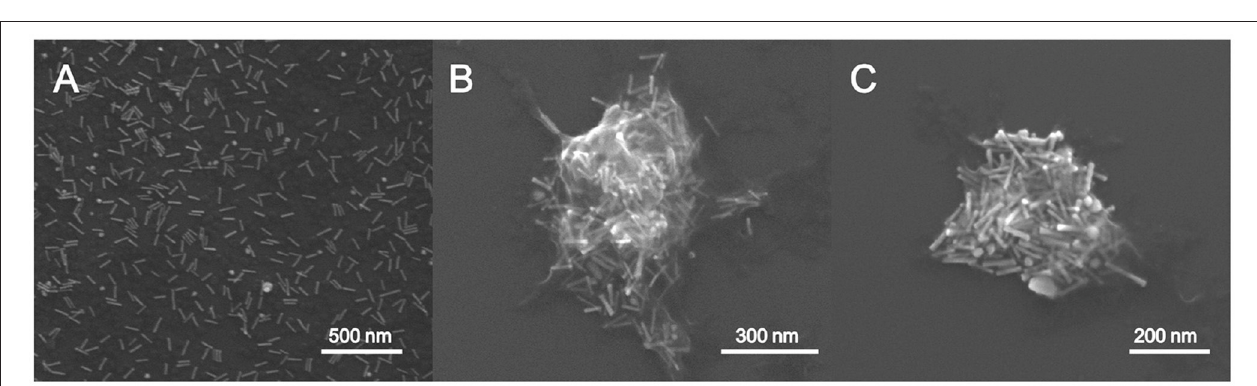
FIGURE 2 | Scanning electron microscopy (SEM) image of AuNR (A) and AuNR@CS (B,C)